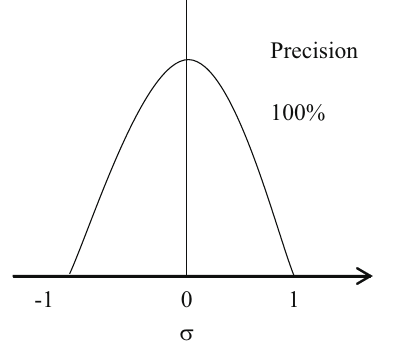
Figure 2: Detection e ff ect.